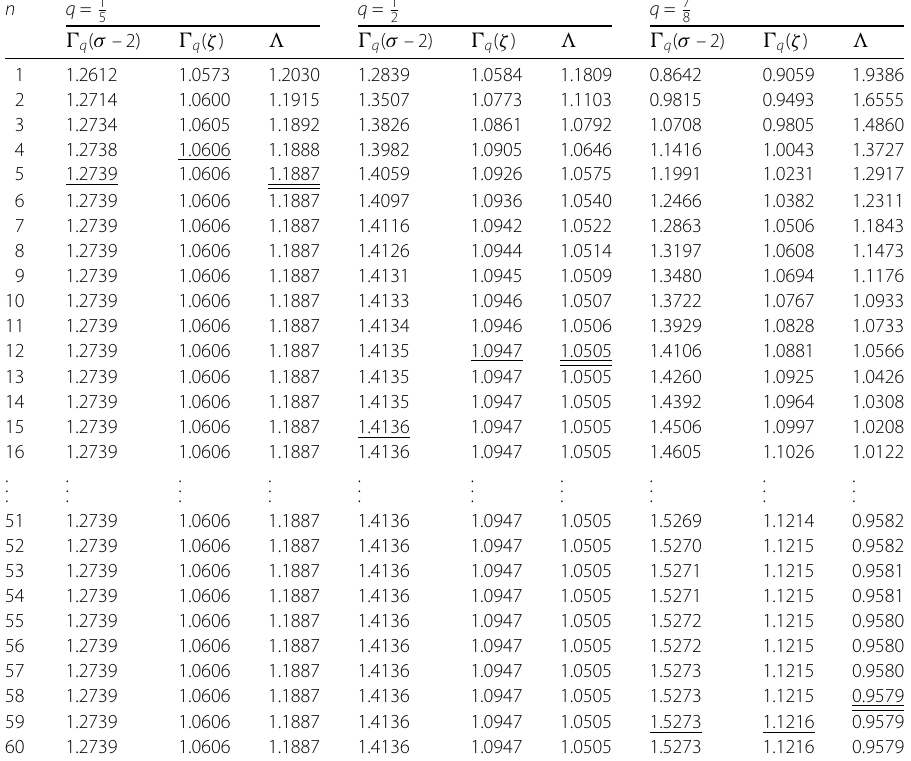
Table 5 Numerical results of (cid:12) q ( σ – 2), (cid:12) q ( ζ ), and (cid:19) = 1+( in Example